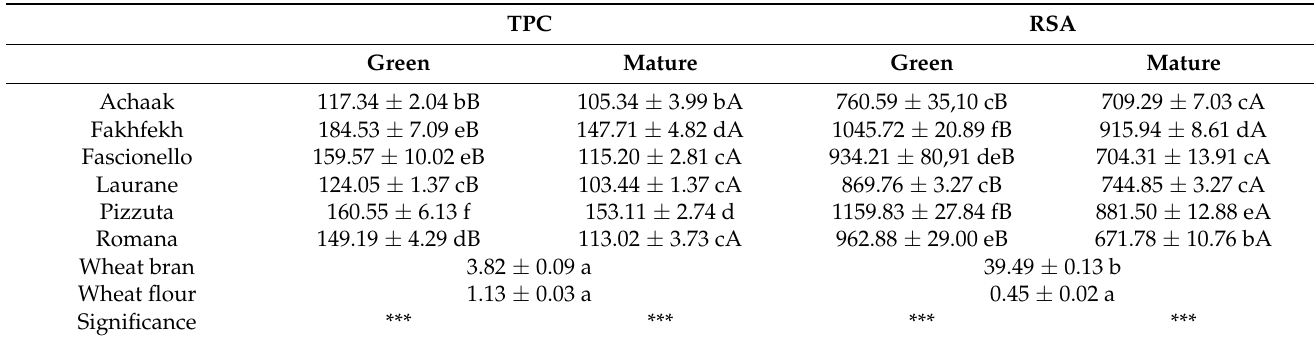
Table 4. Total phenolic content (TPC; mg GAE/g DW) and radical-scavenging activity (RSA; µ mol eq. Trolox/g DW) of AH powders, wheat bran, and wheat flour used for bread production, and results of variance analysis with Duncan’s test ( p < 0.05) performed between the products and the two harvesting times (green and mature). TPC RSA Green Mature Green